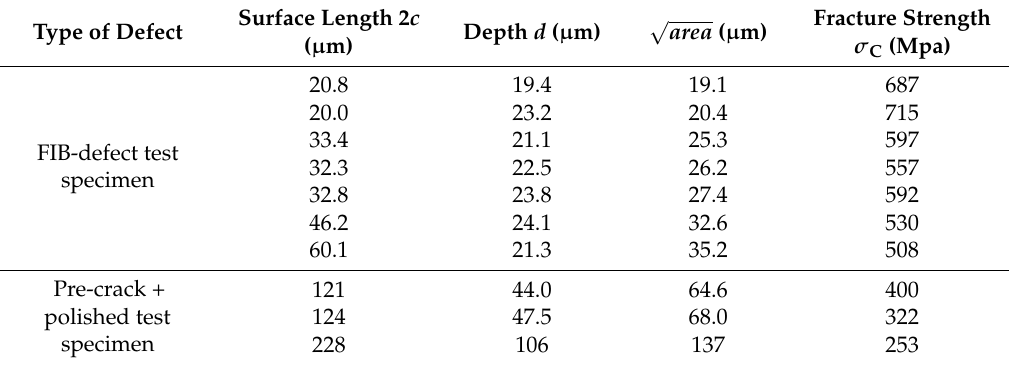
Table 2. Bending test results.